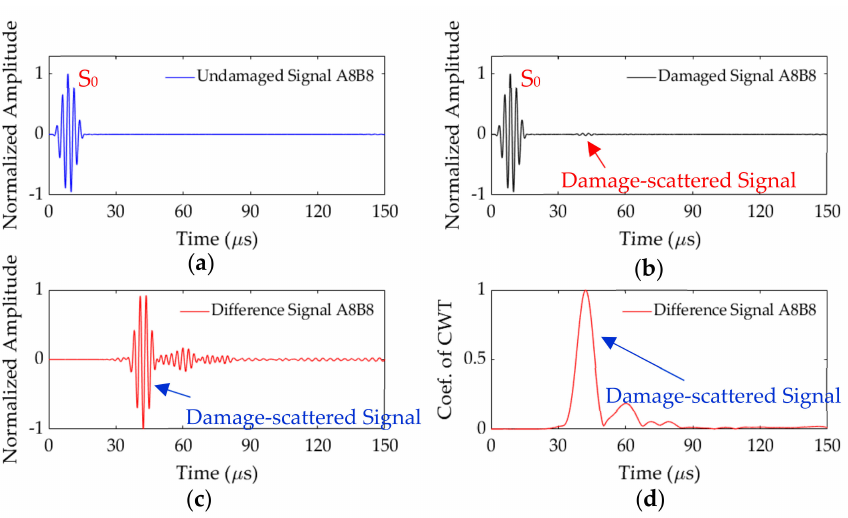
Figure 8. Signals for sensing path A8B8: ( a ) undamaged; ( b ) damaged; ( c ) di ff erence; ( d ) coe ffi cient of CWT.